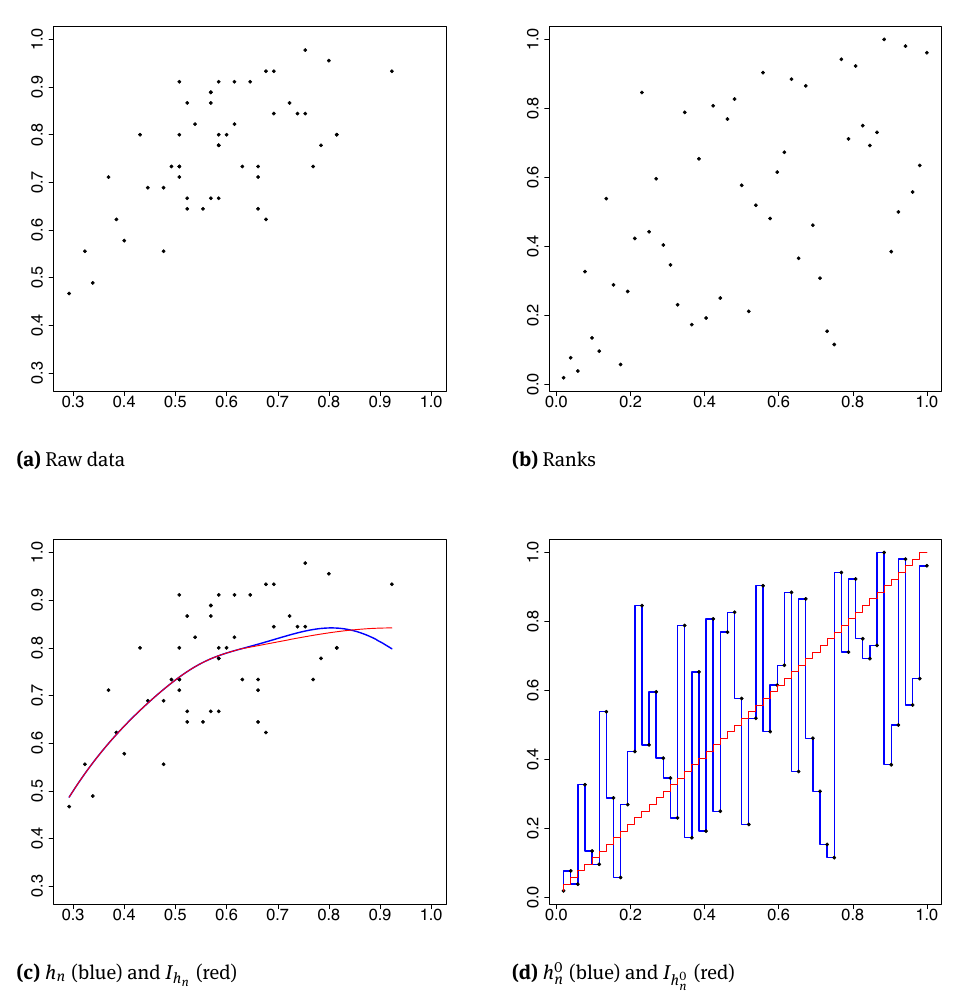
Figure 4: Raw and rank-based scatterplots (with added negligible noise) and fitted